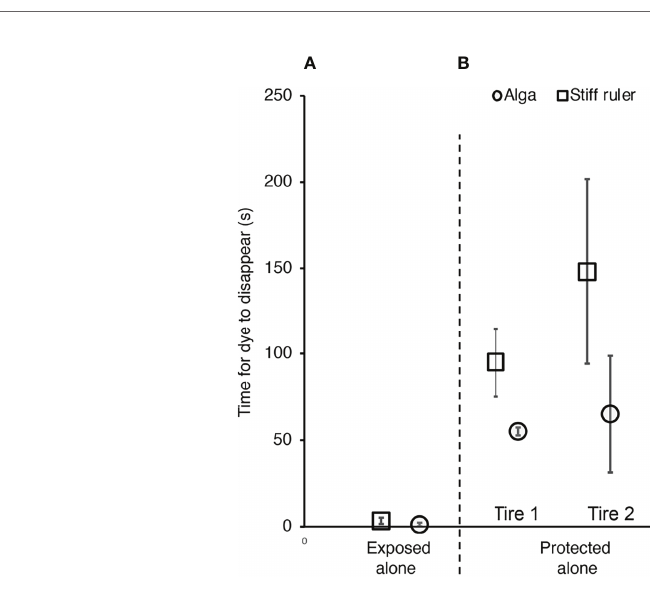
FIGURE 5 | Effect of fl exibility and neighbors on water exchange, as measured by the time for dye to disappear that had been released mid-blade next to a fl exible M. splendens (circles) or a stiff wooden ruler (squares) of the same length (20 cm) at the same position in the fi eld. (A) Exposed site, where an alga or ruler was alone, with all neighboring algae on the tire removed. There was no signi fi cant difference between the time for dye to leave the fl exible alga and to leave the stiff ruler (p > 0.05, one-way ANOVA, F = 2.49 1,14 ). (B) Protected site, where all the algae but one were cleared from two different tires, and each solitary alga was then replaced by a solitary stiff ruler at the same location. Dye left each fl exible alga signi fi cantly faster than it left the rigid ruler (p < 0.05, one-way ANOVA, F = 11.27 1,8 for one location, F = 6.85 1,6 for the other location). (C) At a third location at the protected site, within a canopy of M. splendens. Dye left the fl exible alga signi fi cantly faster than it left the rigid ruler (p > 0.05, one-way ANOVA, F = 227.991 ,11 ). If all data for algae without neighbors are pooled for the protected site, dye leaves algae in a canopy signi fi cantly faster than dye leaves solitary algae (p < 0.05, one-way ANOVA, F = 9.95 1,8 ). In all graphs, error bars represent one standard